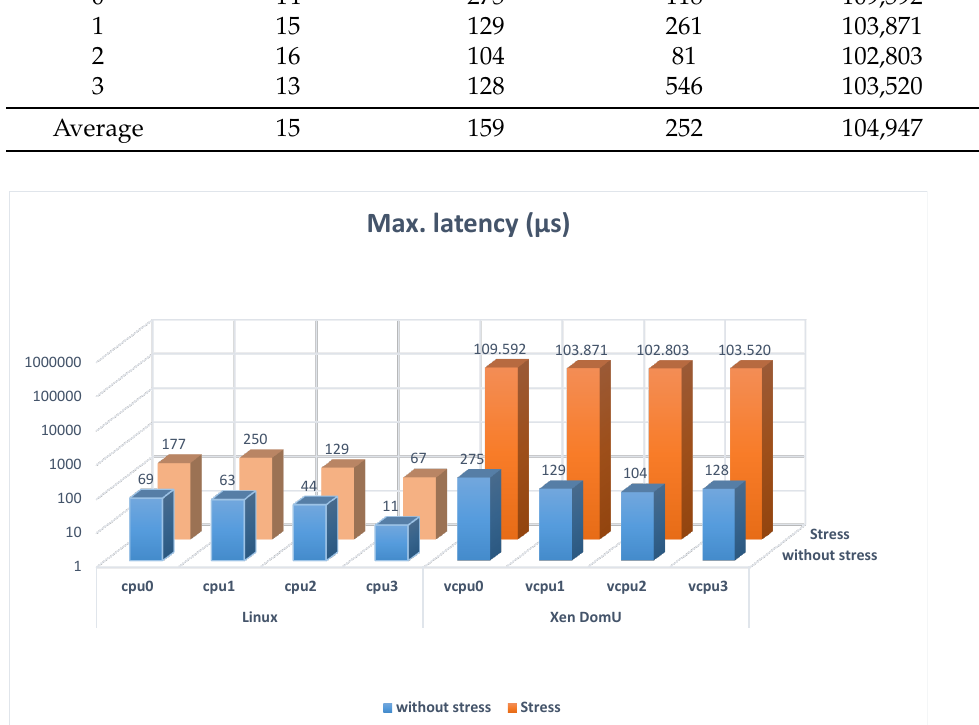
Figure 4. Maximum thread latency in each CPU and vCPU in Linux and Xen DomU with stress and without